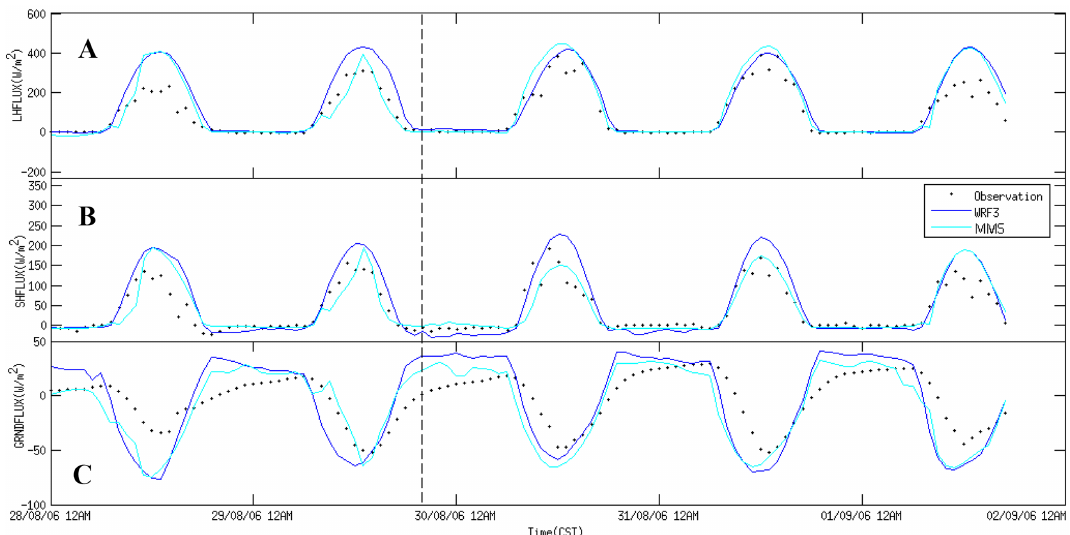
Figure 5. Time series for latent heat (a) , sensible (b) , and ground (c) flux for observations (dots) and for the WRF (blue) and MM5 with EDAS (green)